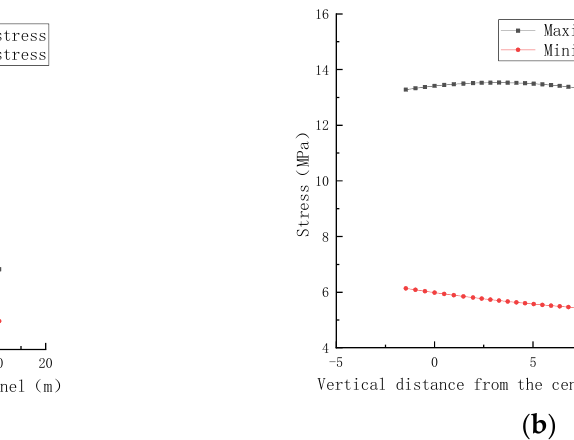
( b ) Figure 15. Principal stress distribution contour of the roadway ’s surrounding rock when the coal column is 4 m. ( a ) σ 1 cloud. ( b ) σ 3 cloud. This can be seen in the main stress variation curve (Figure 16). In the horizontal di- rection, σ